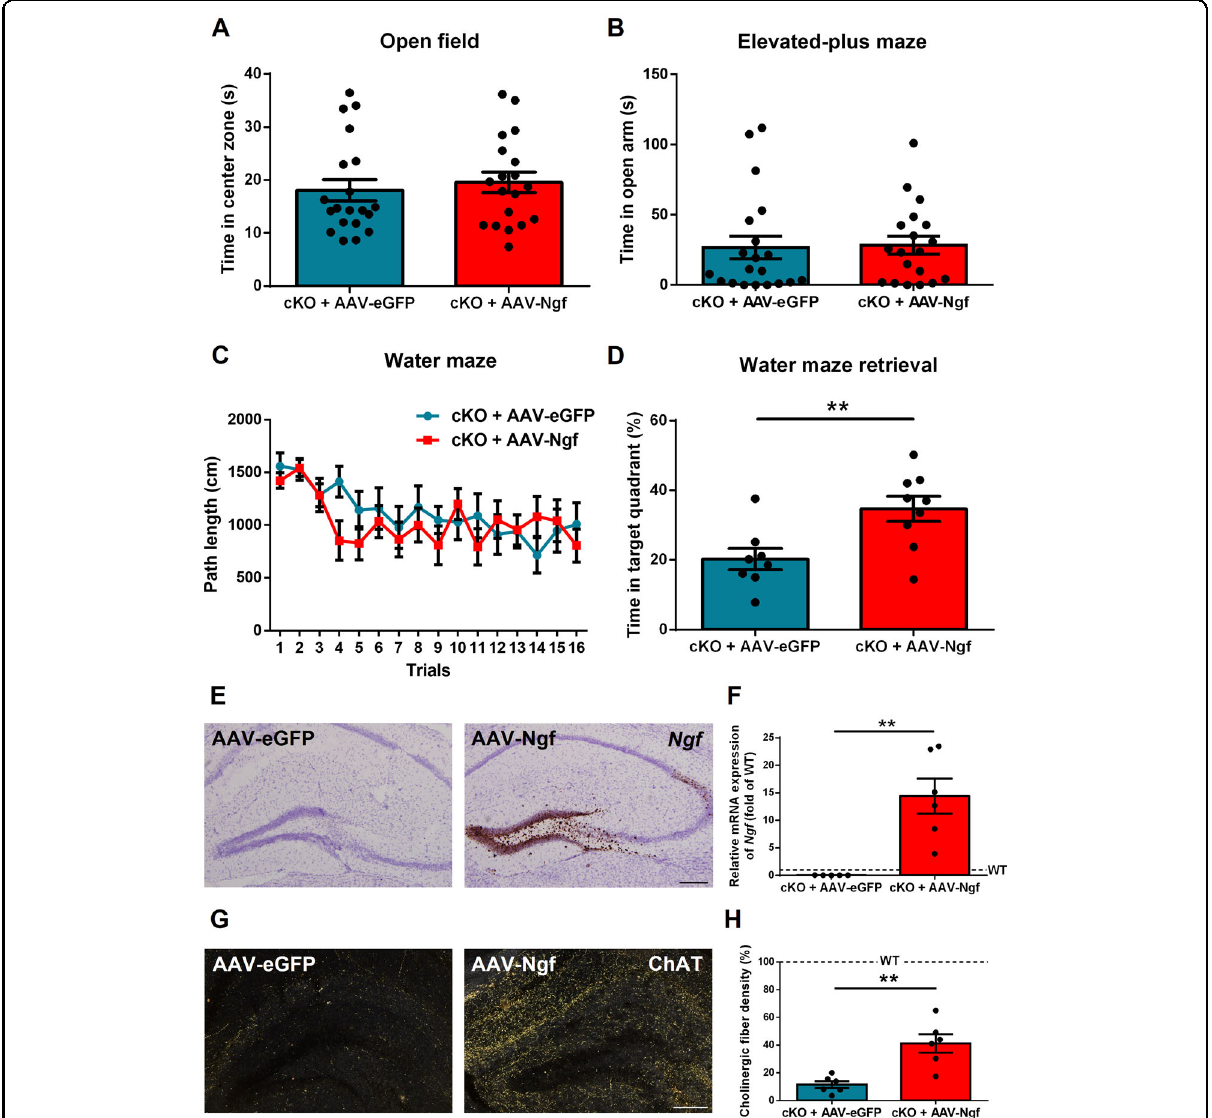
Fig. 3 Overexpression of hippocampal Ngf in knockout mice restore cholinergic innervations and spatial memory. A , B Hippocampal Ngf overexpression (using AAV- Ngf ) on the Ngf cKO background had no effect on the open fi eld or elevated plus maze ( n = 19 – 20). C , D Ngf overexpression did not improve spatial learning ( n = 8 – 9), but did improve spatial memory retention. E Images of Ngf overexpression in the hippocampus by in situ hybridization. F We con fi rm the Ngf overexpression in the hippocampus by real-time PCR ( n = 5 – 6). G , H Images of cholinergic fi bers in AAV-eGFP control and AAV- Ngf mice by ChAT staining. Quanti fi cation of fi ber density revealed that Ngf overexpression partially restored cholinergic fi bers in the hippocampus ( n = 6). Dotted lines represent the levels of age-matched WT naive